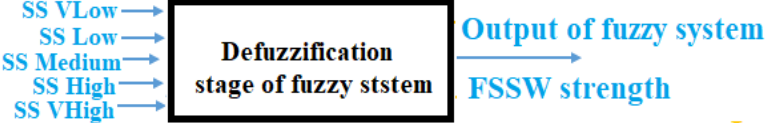
Figure 17. Defuzzification step in FSSW strength (dynamic parameters) fuzzy system. Table 12. Membership functions of FSSW strength fuzzy system